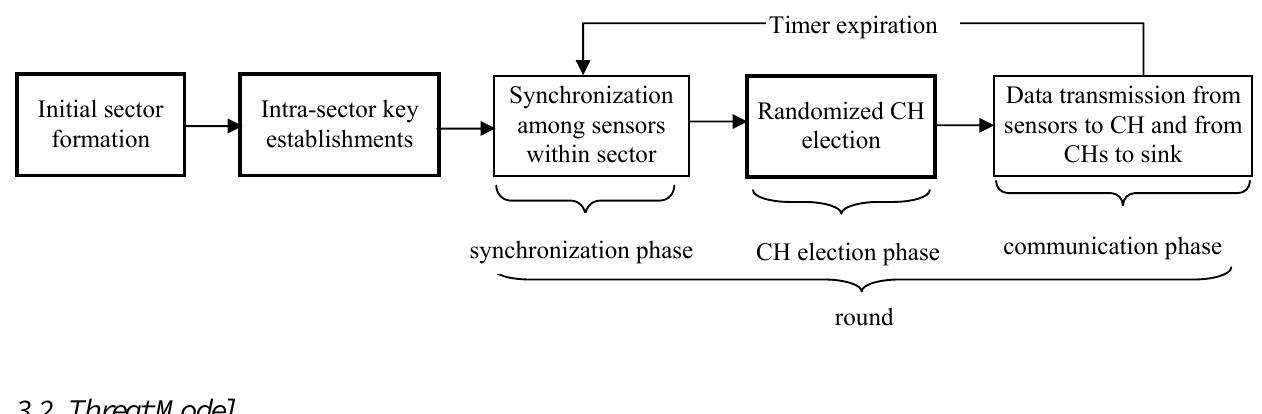
Figure 1. Network operation of clustered sensor